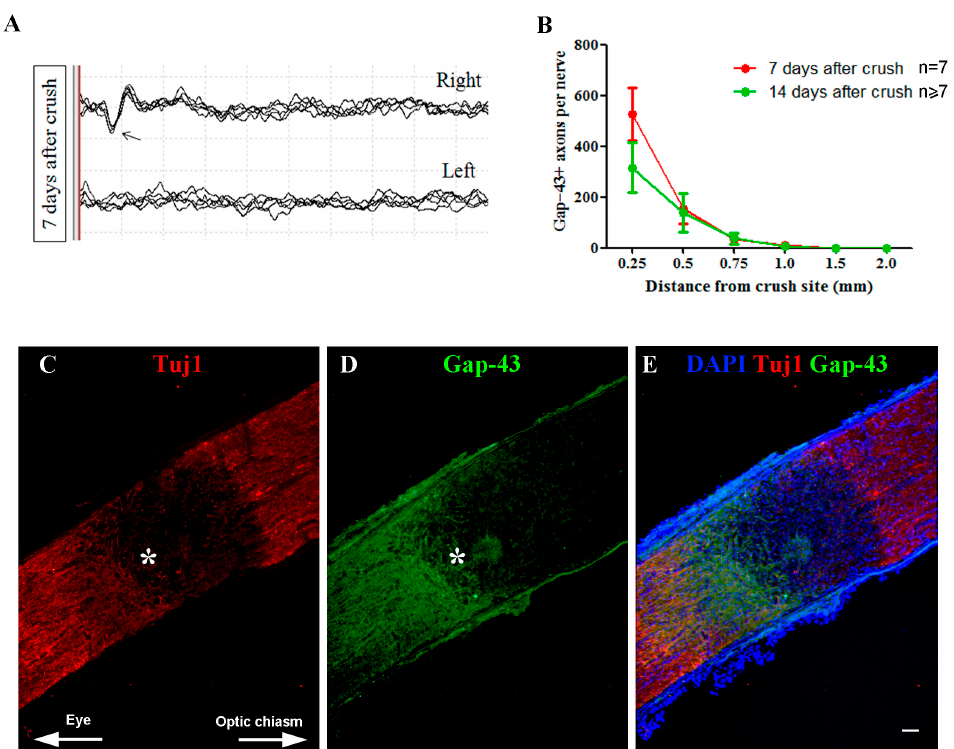
Figure 5. Functional and morphological aspects of the optic nerve after crush injury. ( A ) VEP recording of the CoEye ( right eye) and Crush eyes ( left eye), seven days after the unilateral crush procedure. Upper panel shows the right eye (CoEye) graph, where the arrow indicates the potential P1; Lower panel shows the left eye (Crush) graph, where no potential P1 was evoked; ( B ) Quantification of the number of Gap-43 + axons extending from 0.25 to 1.00 mm beyond the injury site, at 7 and 14 dac; ( C ) Optic nerve expression of Tuj1 at 7 dac; the asterisk indicates the proximal border of the injury site; ( D ) Gap-43+ expression is arrested at the injury site; ( E ) Merge with DAPI (blue). Scale bar: 50 µ m. VEP: visually evoked potentials; CoEye: contralateral eye; dac: days after crush.